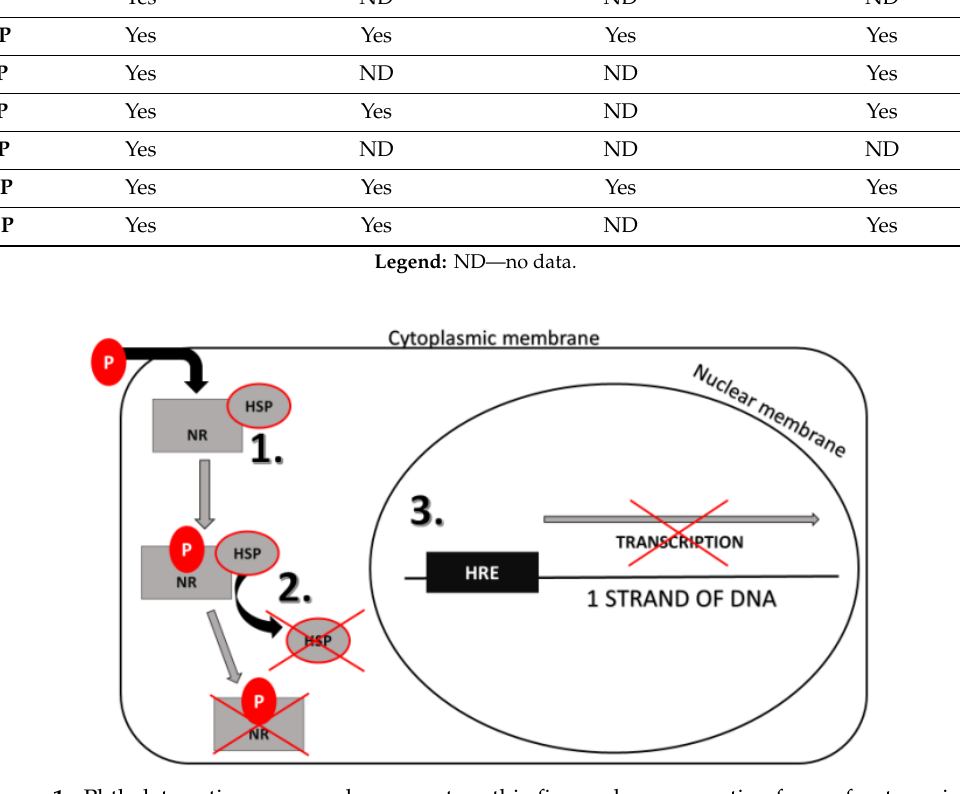
Figure 1. Phthalate action on a nuclear receptor: this figure shows an active form of antagonism when P blocks the conformational change of the complex with NR. 1. P binds to the NR; 2. HSPs cannot dissociate from the P-NR complex; 3. P-NR complex together with HSPs are in an inactive state and this inhibits transcription; HRE-hormone response elements; HSP-chaperones, NR-nuclear receptor, P-phthalate.